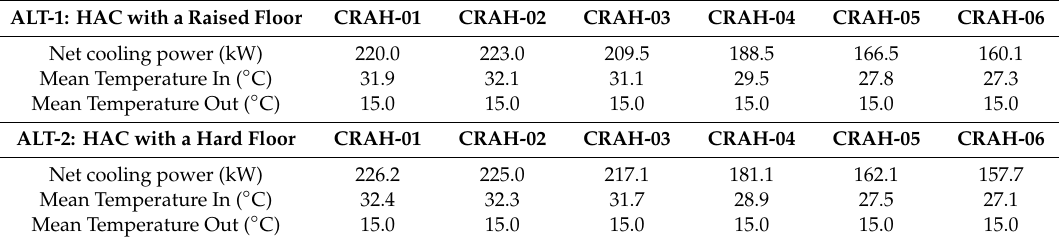
Table 4. Operational net cooling power in normal cooling condition.